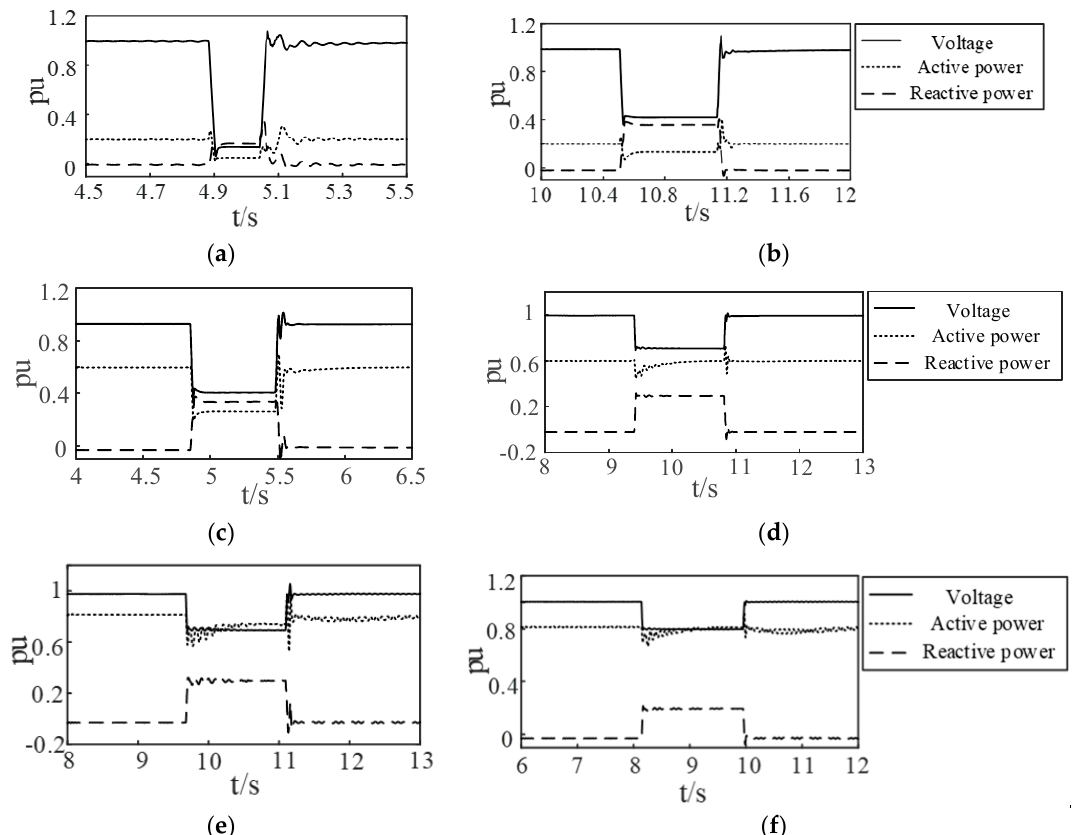
Figure 7. Diagram of electrical variables in real test data: ( a ) operation mode 1; ( b ) operation mode 2; ( c ) operation mode 3; ( d ) operation mode 4; ( e ) operation mode 5; ( f ) operation mode 6.